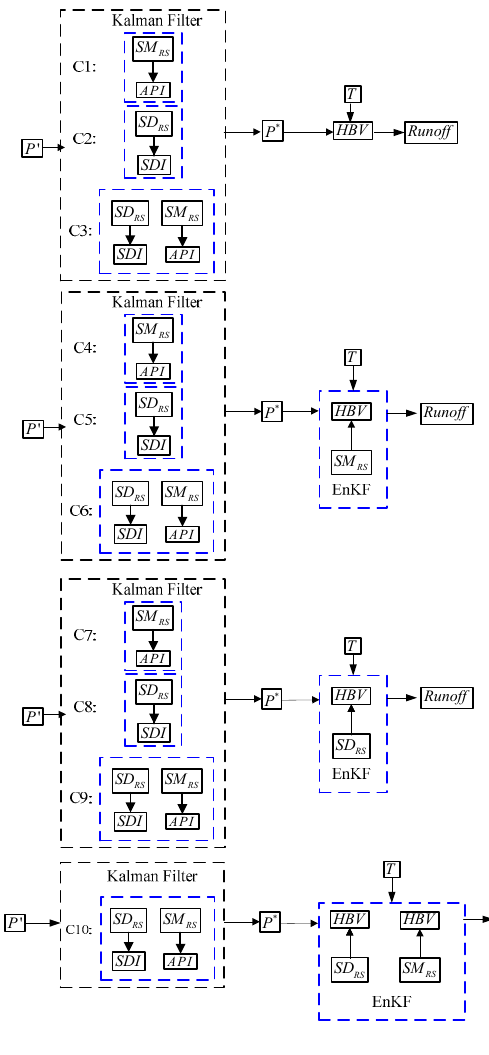
Figure 1. The flowchart for data assimilation cases C1–C10.